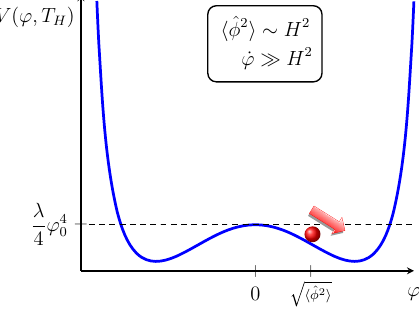
Fig. 3 The onset of classical rolling occurs when the steepness of the potential has increased enough. The initial value for the field is determined by the preceding random-walking epoch when m ∼